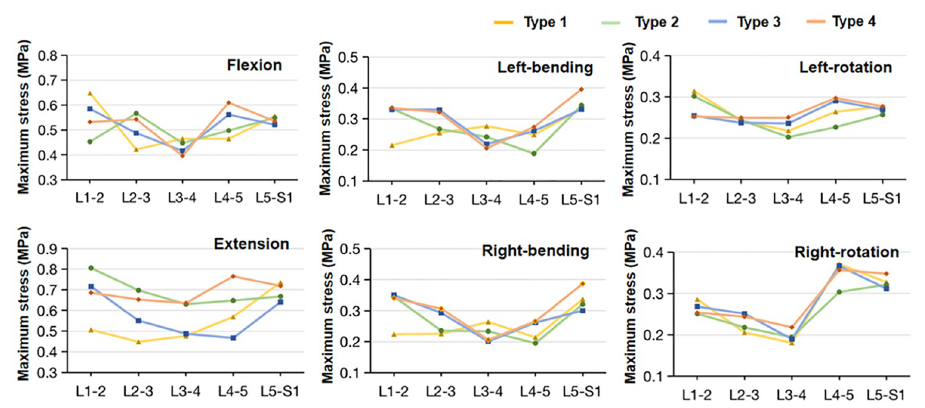
Fig 8. Maximum Von Mises stress of the annulus fibrous matrix of the lumbar-sacral segments in the four sagittal type models under all six loading conditions.